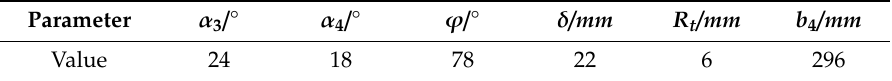
Table 6. Geometry parameter size of guide